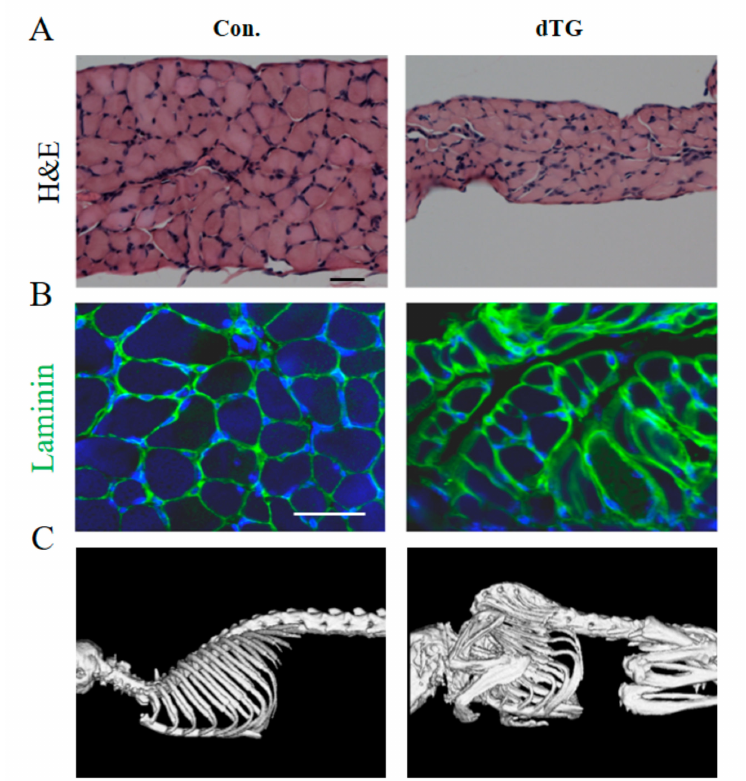
Figure 2. Diaphragm and skeleton of dTG mice display anomalies. ( A ) H&E staining of diaphragm muscles. Scale bars: 50 µ m. ( B ) Immunofluorescence detection of Laminin expression in diaphragm muscles (green represents Laminin), scale bars: 50 µ m. ( C ) X-ray photograph of the control and dTG